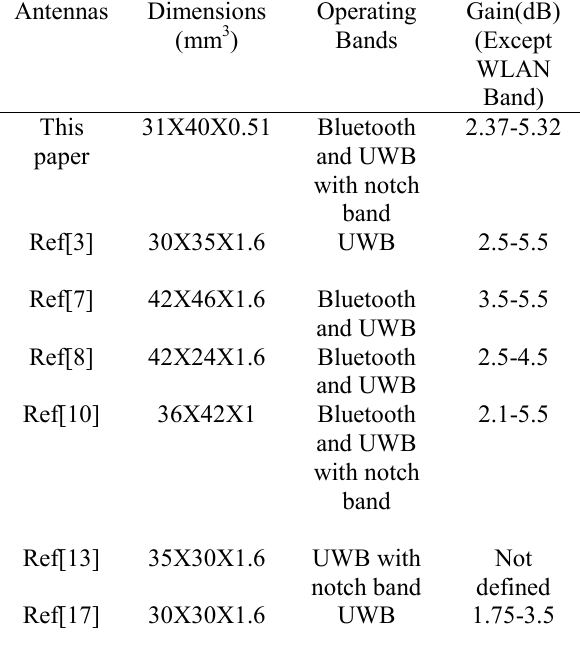
Figure 12: Simulated current distribution of frequencies at.